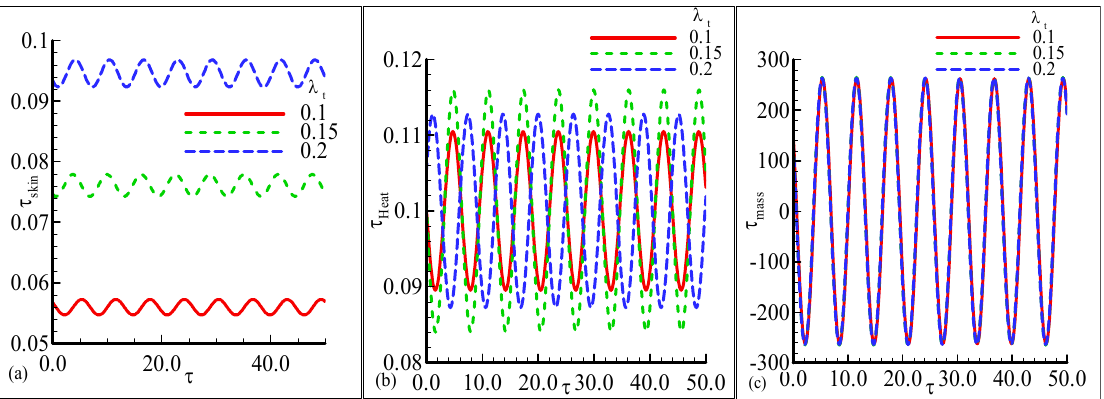
Figure 2. The physical profiles for τ skin , τ heat , and τ mass with choices of λ t = 0.1, 0.15, and 0.2 and fixed Pr = 7.0, S c = 0.2, λ c = 0.6, E = 0.1, γ = 0.1, λ = 0.2, β = 0.5, n = 0.3, and (cid:101) = 0.05.